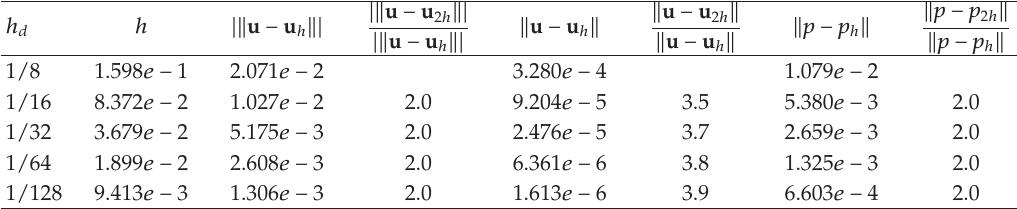
Table 2: Error behavior for scheme (cid:4) 2.42 (cid:6)